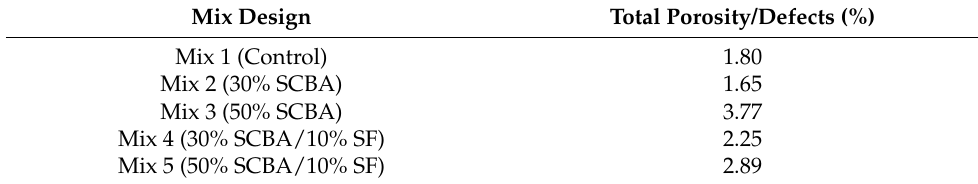
Table 7. Total porosity of all five mix